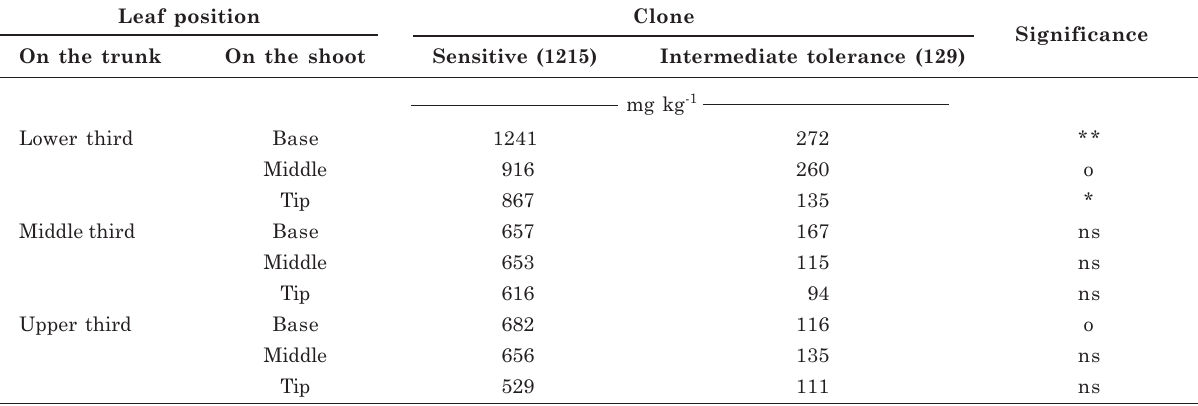
Table 5. Leaf Mn contents in eucalyptus plants (clone with intermediate tolerance, 129, and sensitive clone, 1215, to ESBVRD) in plantations in an area of Neossolo Flúvico (Fluvisol), sampled in the month of February, the initial phase of the anomaly, to 24 months of age in the municipality of Santana do Paraíso, MG,